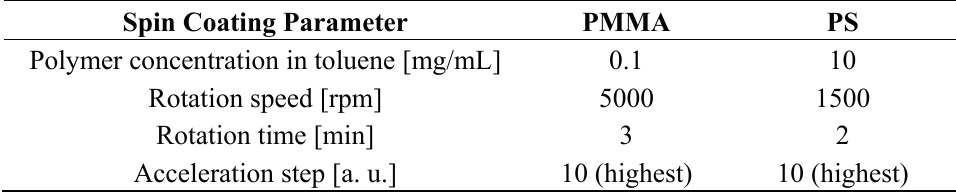
Table 1. Spin coating parameters for PMMA and PS